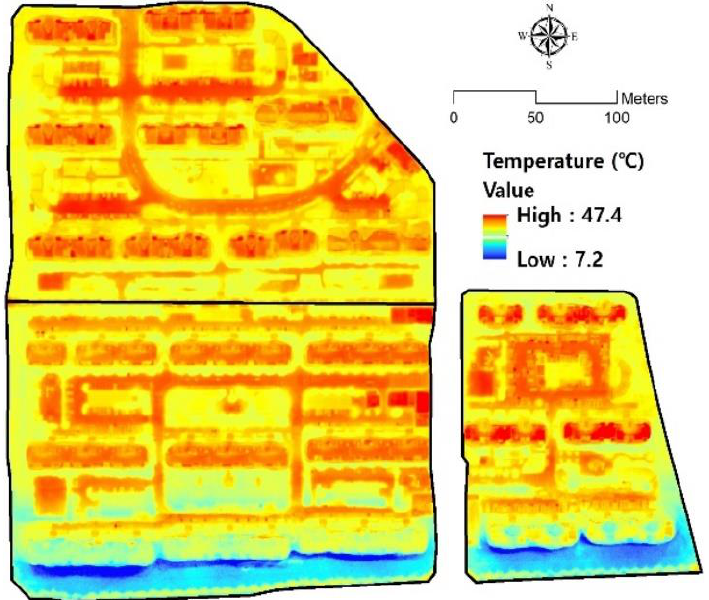
Figure 15. Temperature map analyzed from UAV-based thermal infrared image. The study by Lee et al. (2021) [52] analyzed the temperature distribution characteristics according to the roof material and the type of roof coating. Lee et al. (2021) [52] analyzed the temperature characteristics of the urethane coating area when the average cloud cover was 8.5, and the maximum temperature was 31 ◦ C. The average temperature of the